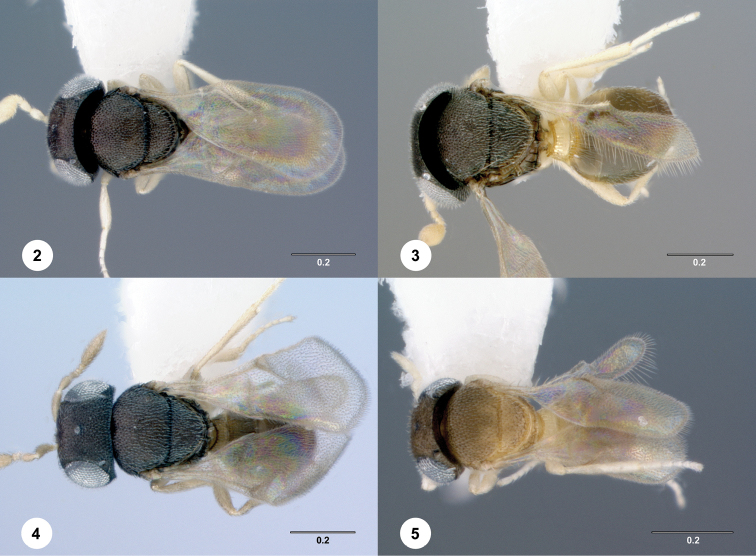
Dorsal habitus. 2Idrisbadius sp. n. 3I.balteus sp. n. 4I.curtus sp. n. 5I.fusciceps sp. n. Scale bars in millimeters.